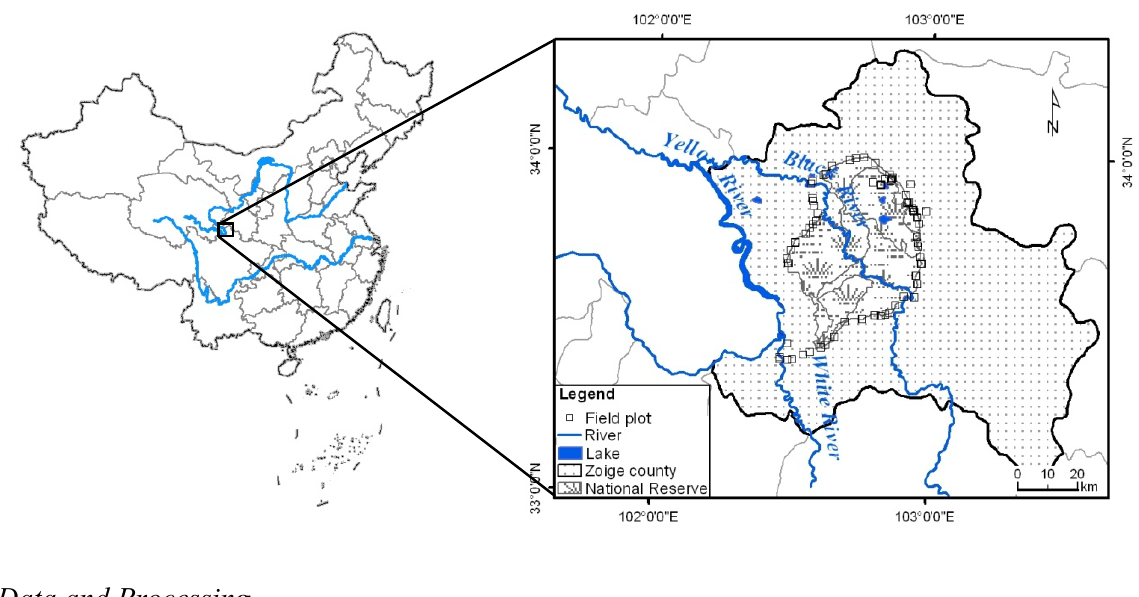
Figure 1. Location of study area, and the spatial distribution of field sample